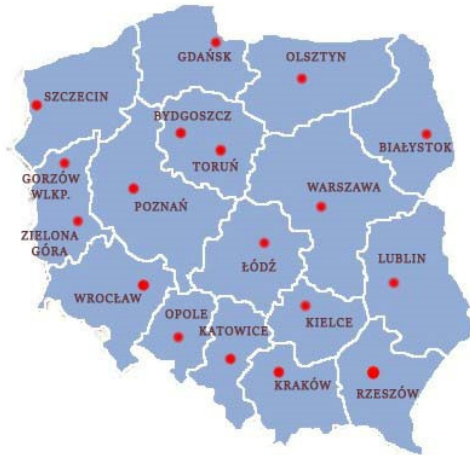
Figure 1. Location of study area with boundaries of voivodships.